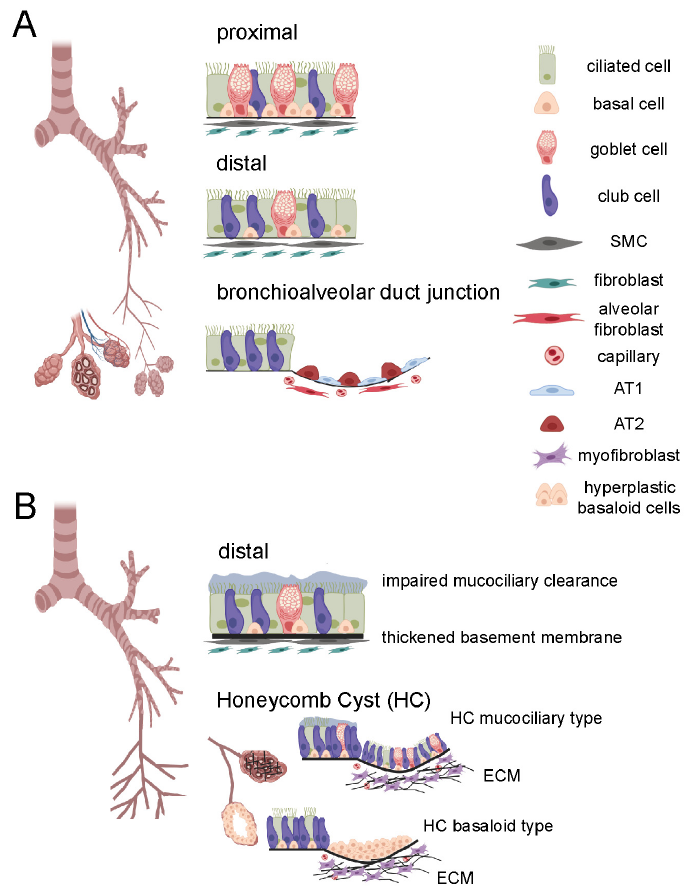
Figure 1. Schematic overview of airways in healthy lung and idiopathic pulmonary fibrosis (IPF). ( A ) Airways in the healthy lung, depicting normal cell type distribution in the proximal and distal airways as well as in the bronchioalveolar duct junction. ( B ) Airways in the IPF lung, depicting dilated bronchioles, impaired mucociliary clearance and the thickened basement membrane in the distal airways, two types of honeycomb cysts (HC, mucociliary, basaloid), and accumulation of ex- tracellular matrix (ECM) in the alveolar region. AT1, alveolar cell type 1; AT2, alveolar cell type II; ECM, extracellular matrix; SMC, smooth muscle cell. Figure was created with biorender.com.